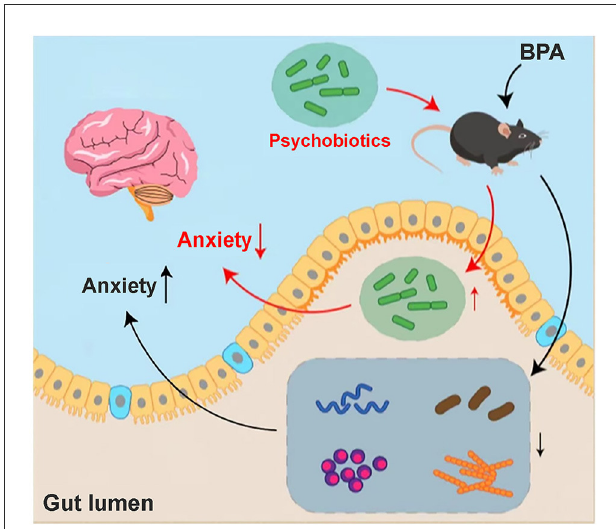
FIGURE7 Hypothesis mechanism diagram of BPA mice. Anxiety-like behavior appeared in the BPA mice, which may be related to the disturbance of intestinal flora and the changes in metabolites after BPA. Through sequencing, we found that a variety of microbiota and its related metabolites involved in the anxiety inhibition decreased significantly, especially Lactobacillus_reuteri. The anxiety-like behavior after BPA can be significantly improved by the addition of intestinal psychoprobiotics, but the specific mechanism of brain-gut axis regulation still needs to be further